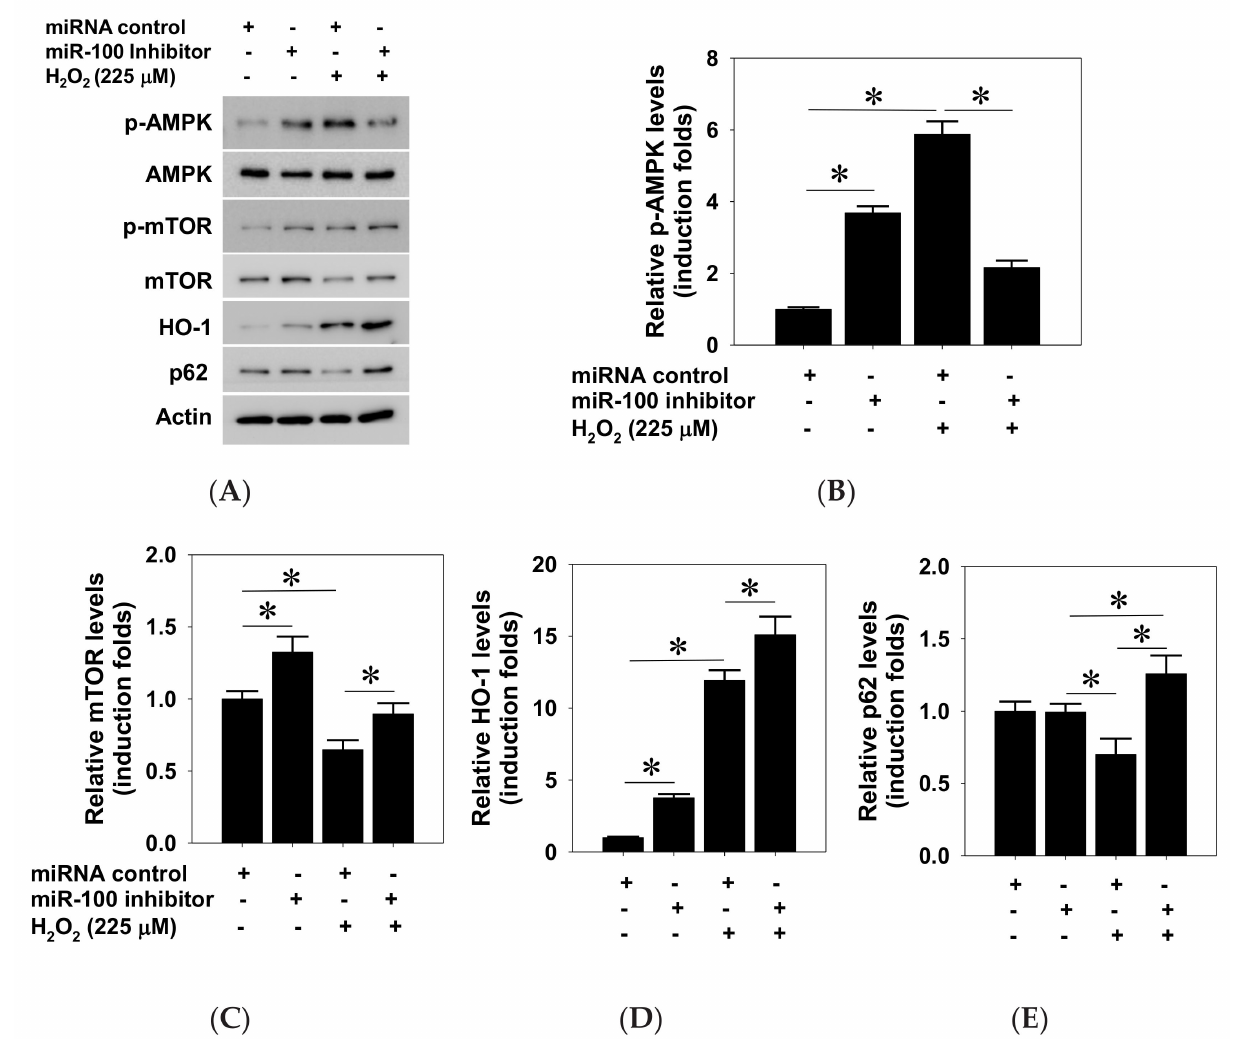
Figure 6. Effects of miR-100 inhibition on AMPK/mTOR signaling and heme oxygenase 1 (HO-1) expression in human ARPE-19 cells. ARPE-19 cells were transfected with either an miR-100 inhibitor or negative miRNA control nucleotides for 24 h followed by H 2 O 2 exposure at 225 µ M for another 24 h. After treatments, cellular protein lysates were collected for western blotting detection ( A ) and subsequent densitometry analysis for p-AMPK ( B ), total mTOR ( C ), HO-1 ( D ), and p62 levels ( E ). Data are expressed as mean ± SD from three independent experiments. * p < 0.05 between indicated groups by ANOVA. +/ − indicates presence/absence of